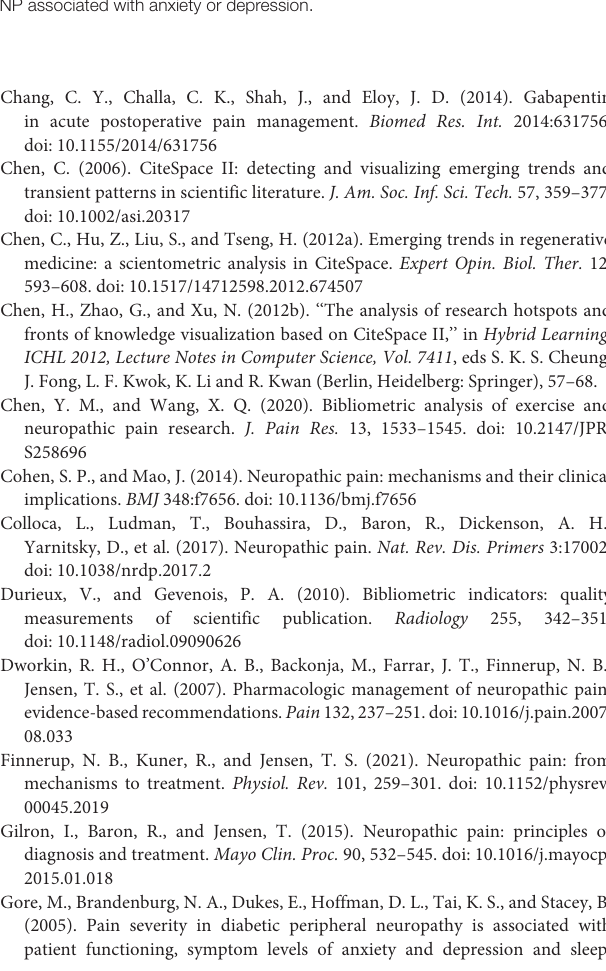
SUPPLEMENTARY FIGURE 1 | Overview of the paper selection